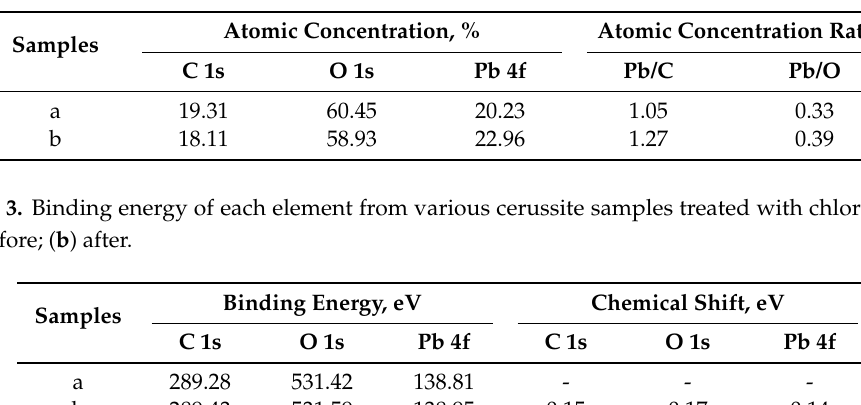
Table 2. Atomic concentration of cerussite samples treated with chloride ions: ( a ) before; ( b ) after.